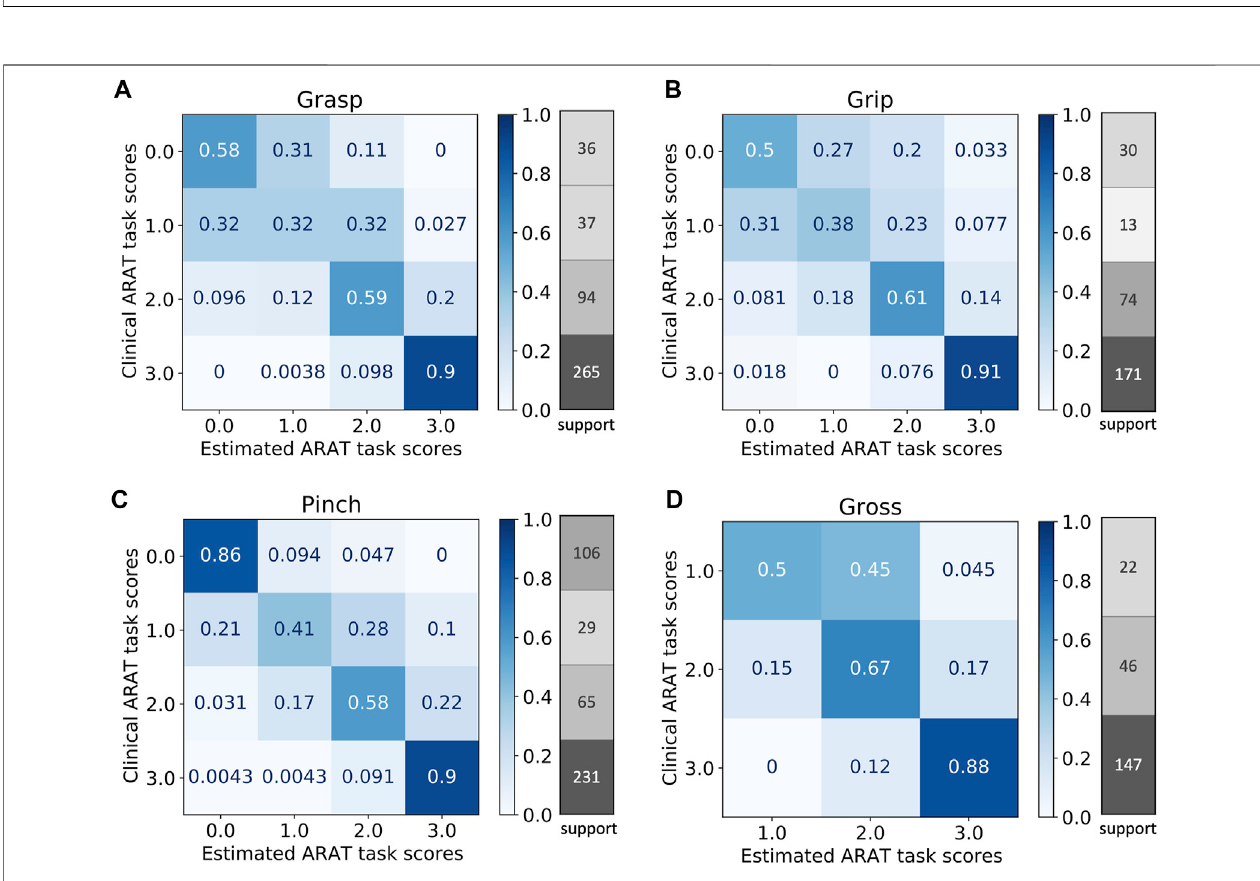
FIGURE 3 | Normalized confusion matrices and number of observations per class (support) for the four domains: grasp (A) , grip (B) , pinch (C) , and gross (D) .